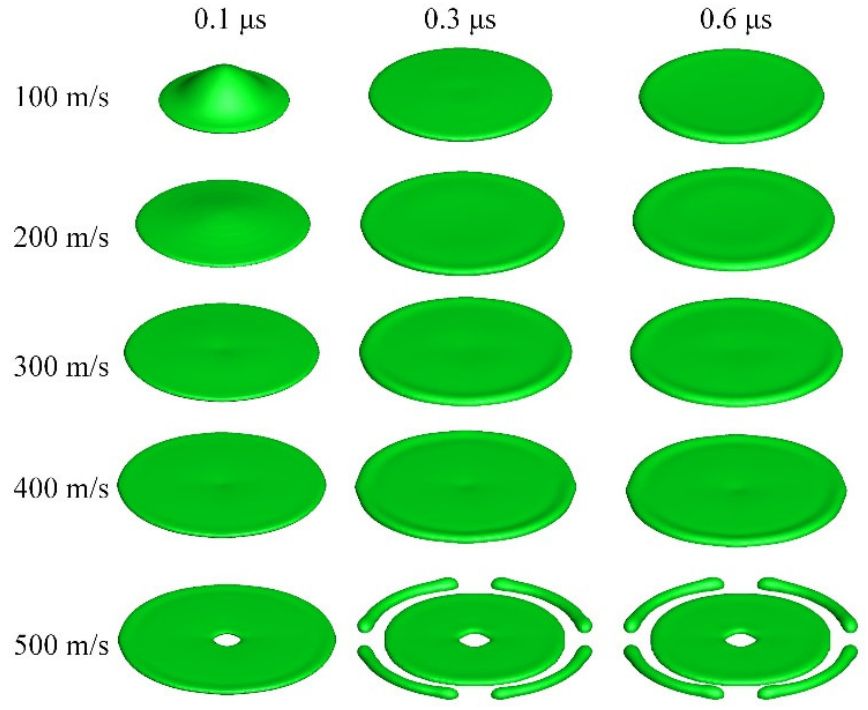
Figure 11. Effect of velocity on YSZ drop spreading.